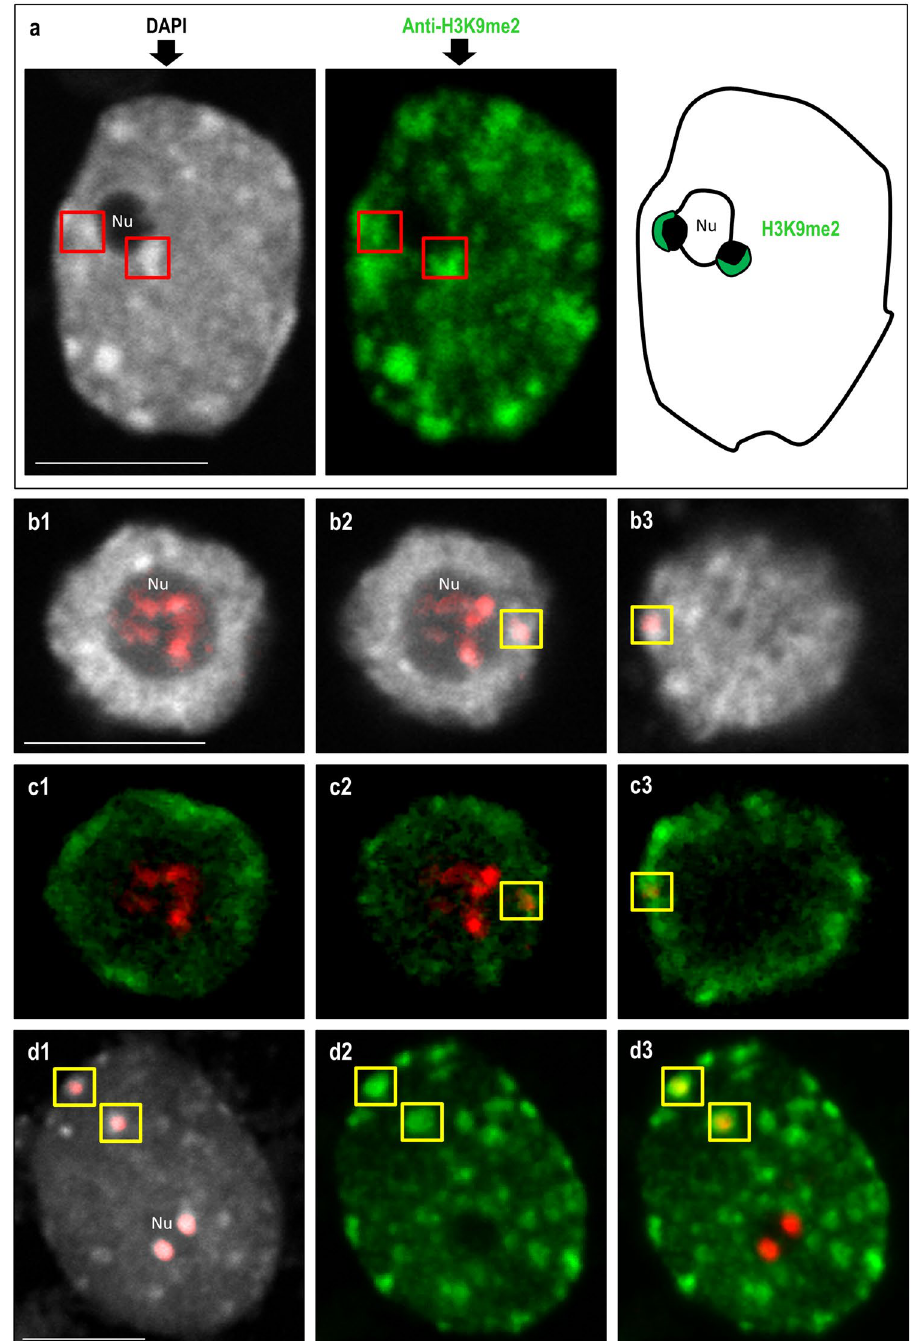
Figure 6. Distribution of heterochromatic marker H3K9me2 in the nuclei of B. hybridum . (a) H3K9me2 immunopattern in the chromocentres adjacent to the nucleolus. ( b1–b3 ; c1–c3 ) H3K9me2 foci distribution in the nucleus without distinct heterochromatic domains. Three example sections through the representative nucleus are presented. (b1–b3) FISH with 25S rDNA (red) as a probe. (c1–c3) H3K9me2 foci (green) distribution and 25S rDNA FISH signals (red) in the sections through nucleus presented on (b1–b3) . (d1–d3) H3K9me2 foci distribution in the nucleus with chromocentres. (d1) FISH with 25S rDNA (red) as a probe. (d2) H3K9me2 foci distribution in the nucleus shown on (d1) . (d3) H3K9me2 foci (green) distribution and 25S rDNA hybridisation signals (red) in the nucleus presented on (d1) . The locations of B. stacei -originated 35S rDNA loci are indicated by yellow insets. Nu–nucleolus. Scale bar: 5 µ